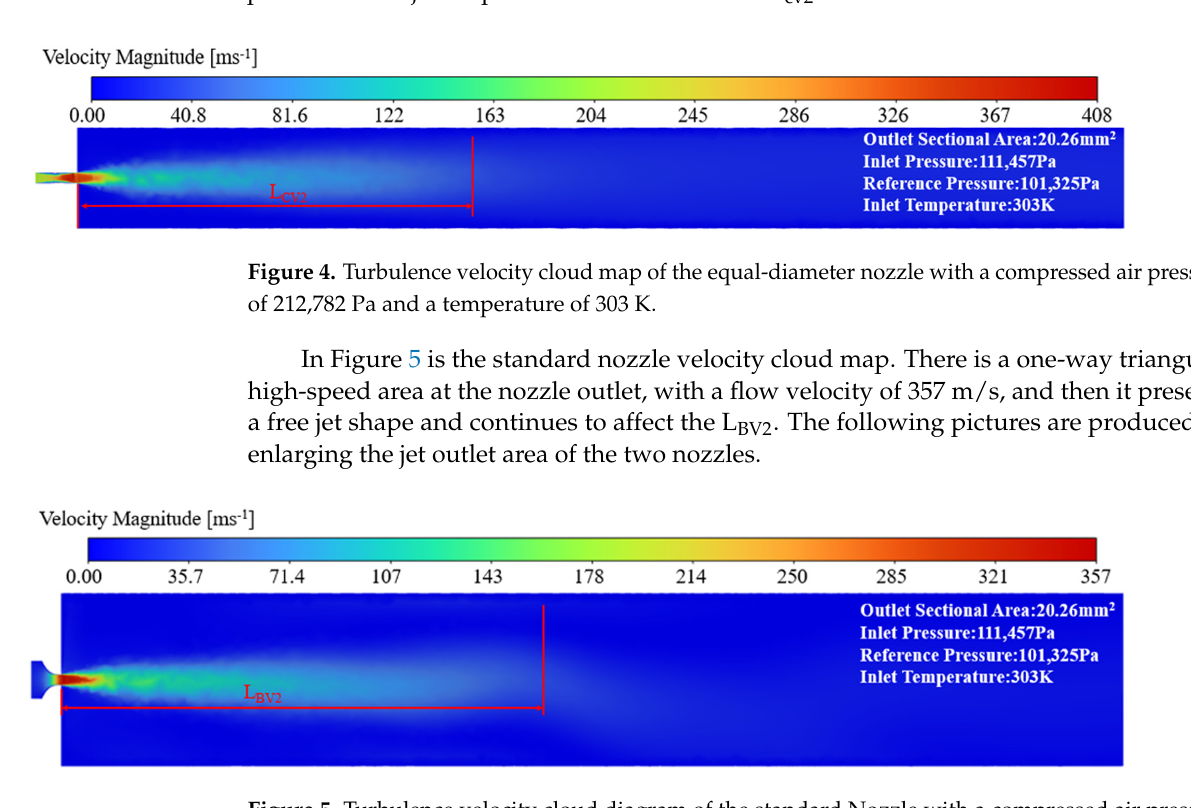
Figure 5. Turbulence velocity cloud diagram of the standard Nozzle with a compressed air pressure of 212,782 Pa and a temperature of 303